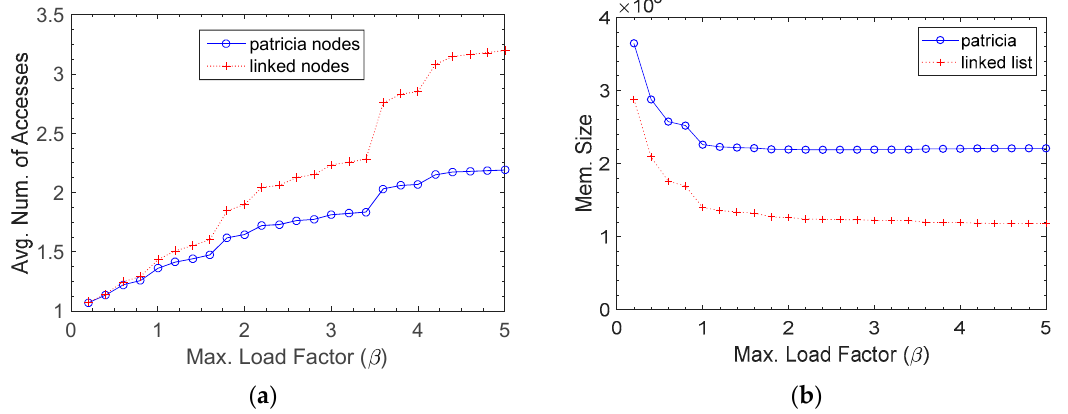
Figure 13. Comparison of a Patricia and a linked list: ( a ) average number of node accesses and ( b ) required memory size.